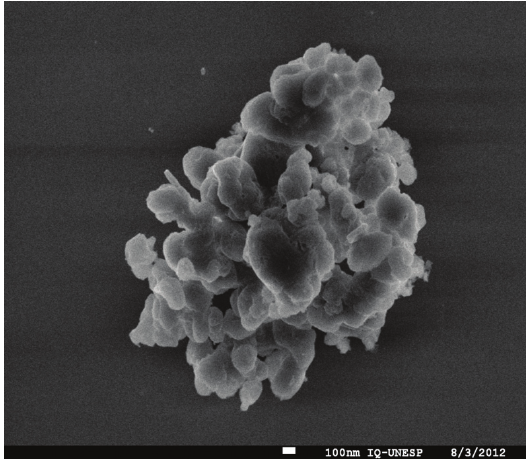
Figure 2. Scanning electron microscopy of calcined